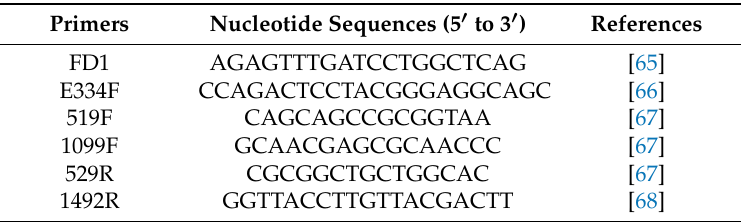
Table 1. Nucleotide sequences for PCR amplification and sequencing primers. Primers Nucleotide Sequences (5 (cid:48) to 3 (cid:48)